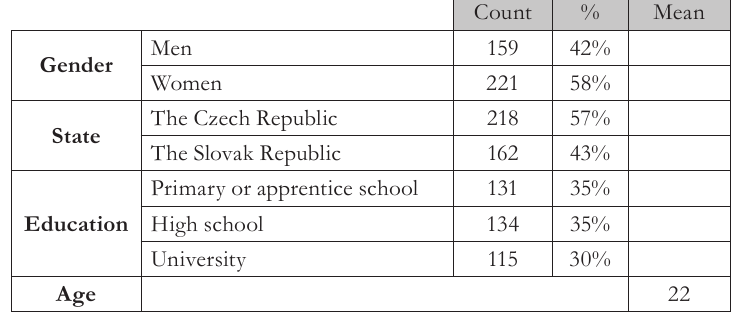
Tab. 1 – Structure of the Sample. Source: Author’s Own.